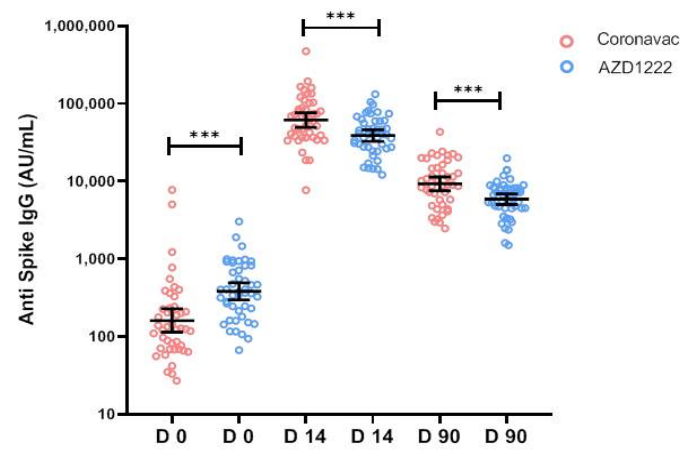
Figure 4. The geometric mean titer of anti-SARS-CoV2-receptor binding domain IgG before, D14 and D90 after booster vaccination with mRNA-1273 in participants who received two doses of CoronaVac and two doses of AZD1222. *** represented p value < 0.001.